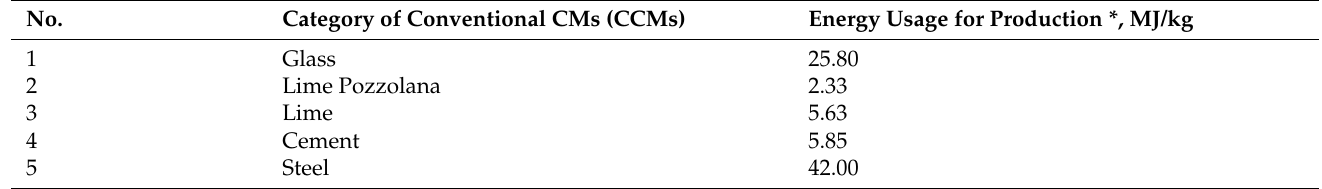
Table 3. Energy consumption during production of five different but typical CCMs.